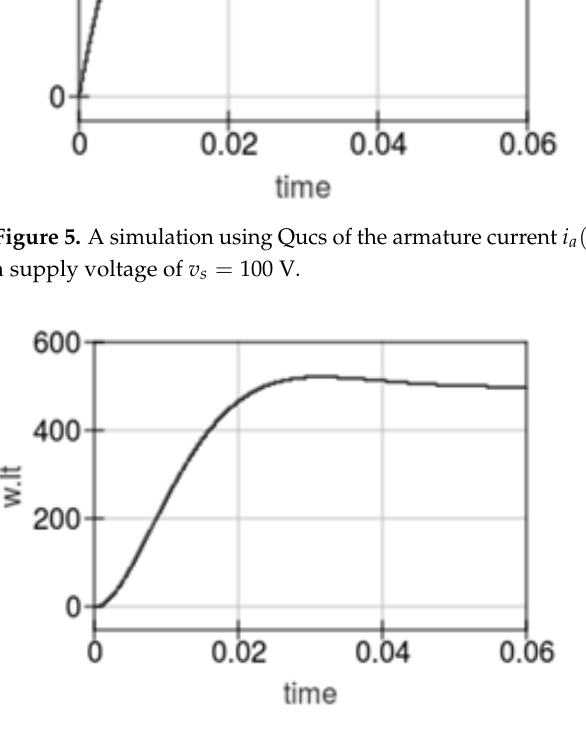
Figure 6. A simulation using Qucs of the rotor speed ω ( t ) under no-load conditions when using a supply voltage of v s = 100